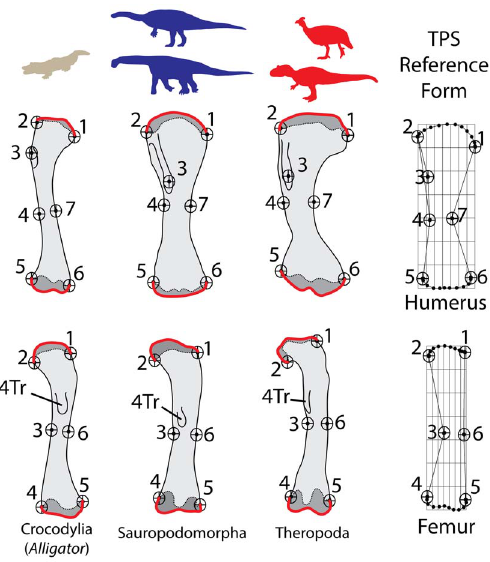
Figure 1. Landmarks digitized for 2-D thin-plate splines (TPS) geometric morphometrics (GM) analyses – Mammals. All drawings are not to scale and were enlarged or reduced to facilitate comparisons. For the humerus, landmarks 1 and 2 encompass the region between the greater tubercle and the medial extent of the humeral head. Landmarks 2, 3, and 4 encompass the extent of the deltopectoral crest. Landmarks 4 and 7 encompass the narrowest point of the midshaft. Landmarks 5 and 6 denote the lateral and medial epicondyles, respectively. For the femur, landmarks 1 and 2 encompass the region between the greater trochanter and the medial extent of the proximal end of the femur. Landmarks 3 and 6 encompass the narrowest point of the midshaft. Landmarks 4 and 5 denote the the lateral and medial epicondyles. Regions of sub-articular bone are indicated in dark gray and the digitized outlines that were subsequently converted into chains of 10 evenly-spaced semi-landmarks are colored red. The exemplar taxa represented as bones, left to right, are: Ornithorhynchus , Mammut , and Paraceratherium . The TPS reference forms which describe the shape of the bones mathematically is shown at right.